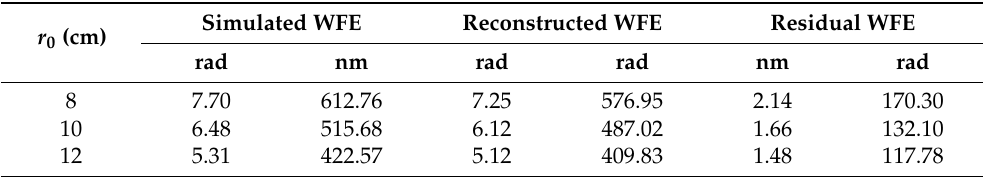
Figure 3. Comparison for 𝑟 (cid:2868) = 8 cm. The residual WFE for this case is 180.85 nm, higher than the mean value obtained over the test. The original phase is placed on the left, with the reconstructed one shown on the right.